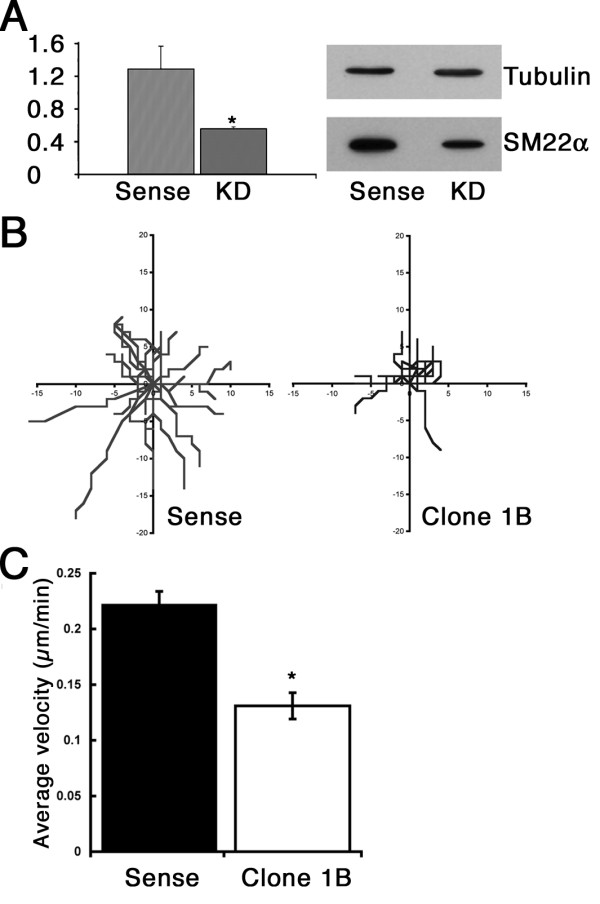
Effect of SM22α depletion on cell motility. Stable depletion of SM22α by expressing shRNA achieved 57% knockdown in REF52 cell Clone 1B, compared to cells expressing a control sense RNA hairpin (A). Cell migration was inhibited in SM22 knockdown cells, single cell trajectories were reduced in Clone 1B compared to sense control (C), which was matched by a significant reduction in average velocity (D). Data shown are mean ± SEM in A, C. A n = 3, p < 0.05 compared to Sense, C n = 20, p < 0.02 compared to Sense.